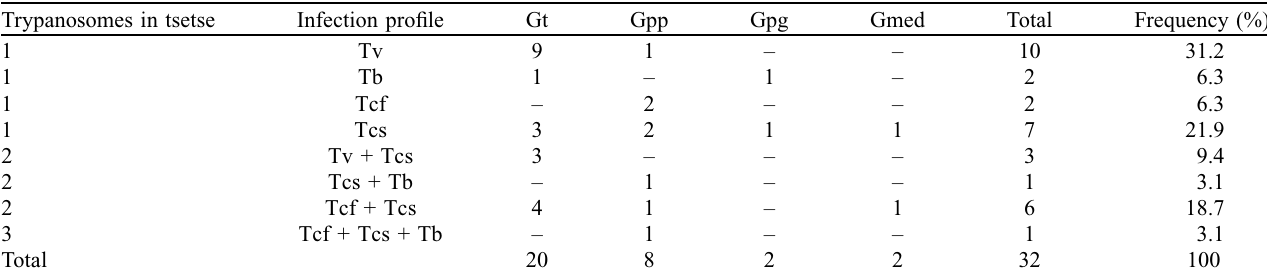
Gt: G. tachinoides , Gpg: G. p. gambiensis , Gpp: G. p. palpalis , Gmed: G. medicorum , Tv: T. vivax , Tb: T. brucei s.l, Tcf: T. congolense forest type, Tcs: T. congolense savannah type.